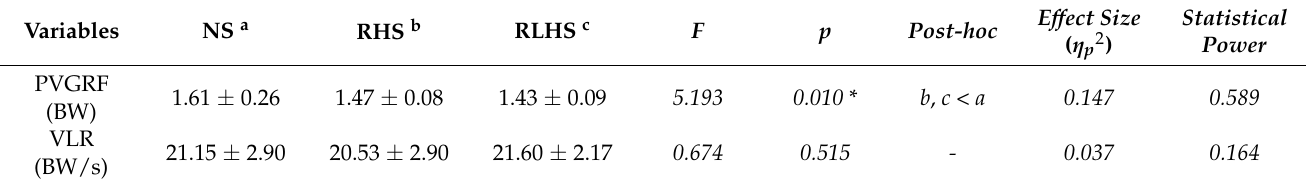
Table A1. Descriptive information for impact variables during the stance phase of running.